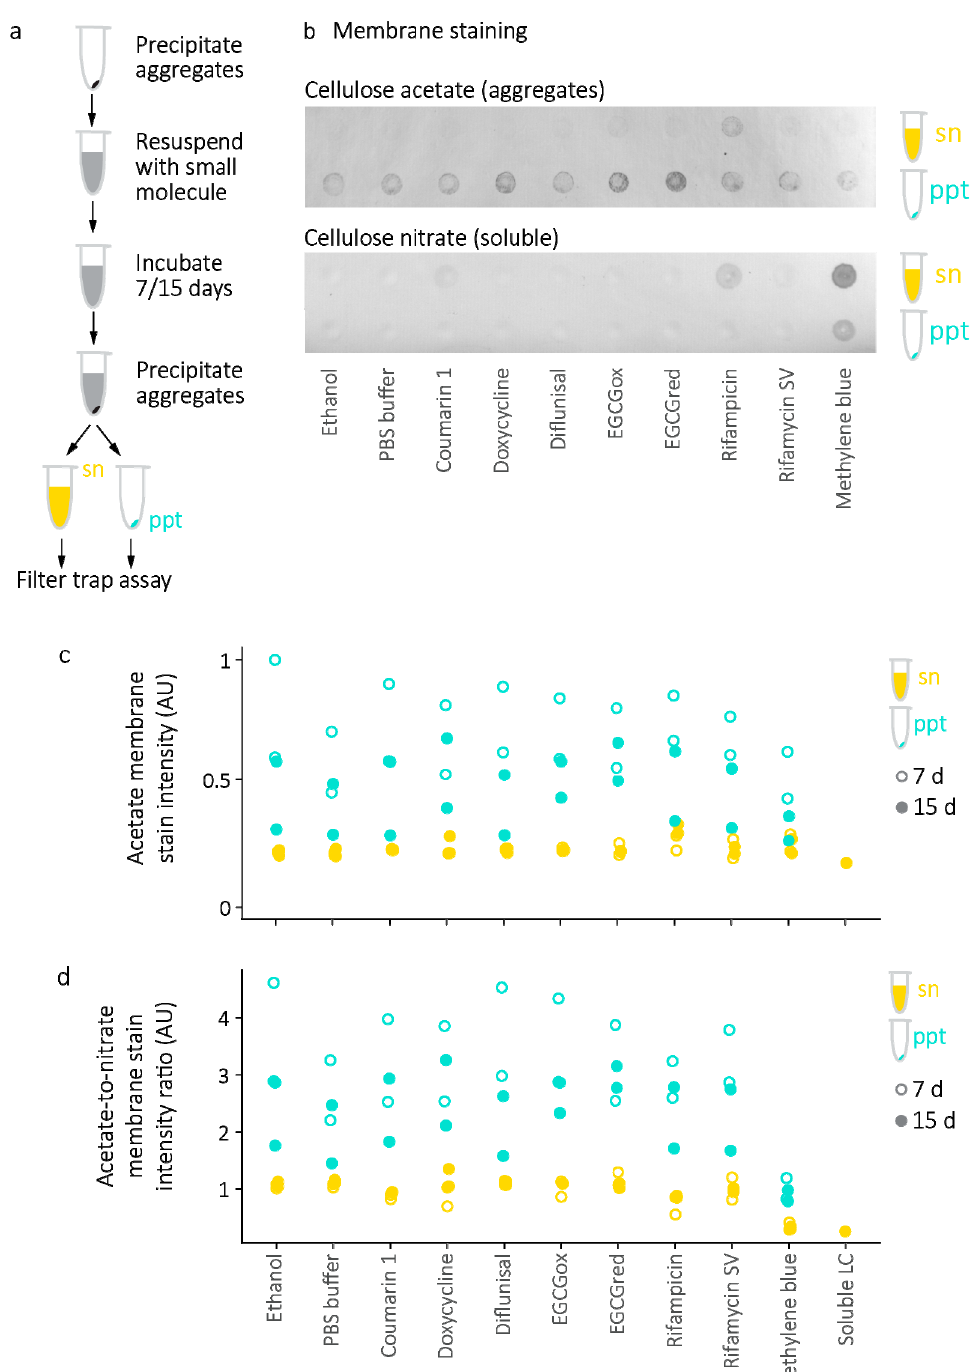
Figure 9. Dissociation of pre-formed amyloid fibrils measured by the filter trap assay. ( a ) Experimental outline. Pre-formed fibrils ( n = 2 samples per condition) were incubated with small molecules for 7 or 15 days, after which bulk aggregated LCs were precipitated by centrifugation. The soluble and insoluble LC in the supernatant (sn, orange) and precipitate (ppt, blue) were measured by the filter trap assay. ( b ) Example membranes showing aggregated (cellulose acetate membrane stain) and soluble (cellulose nitrate membrane stain) LC in the supernatant and precipitate of one set of samples incubated for 7 days. ( c ) Total aggregate levels in each sample, relative to the most-stained membrane region. ( d ) Ratio of aggregated to soluble LC after 7 days (hollow symbols) or 15 days (solid symbols). The reduced apparent aggregation observed in the presence of methylene blue appears to be due to staining of the cellulose nitrate membrane by the small molecule. Symbols are colored as for panel ( c ).